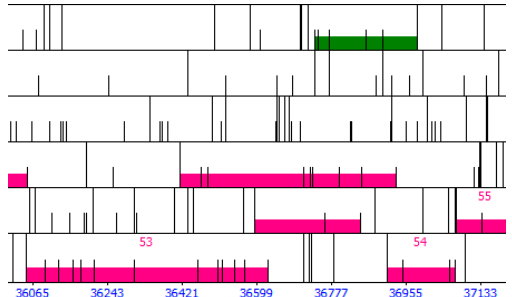
Figure 6. Examples of overlap as visualized in DNA Master. There are three putative user-identified genes located in the gap between gene 53 and gene 54 (two reverse, one forward). The putative gene in reverse frame 1 (row 4) overlaps with gene 53 and gene 54; the putative gene in reverse frame 2 (row 5) overlaps with gene 53; the putative gene in forward frame 1 (row 1) overlaps with gene 54. The putative gene in reverse frame 1 appears to form an operon with gene 54 (4 bp overlap). There is